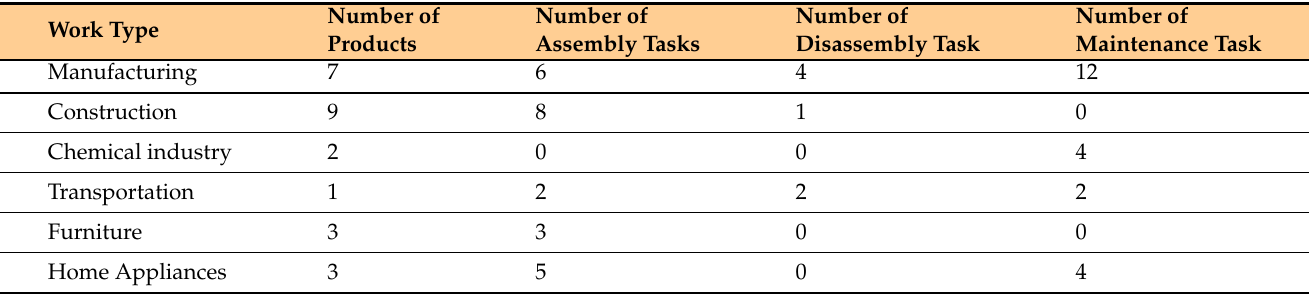
Table 5. This table shows the number of guide books we have collected for